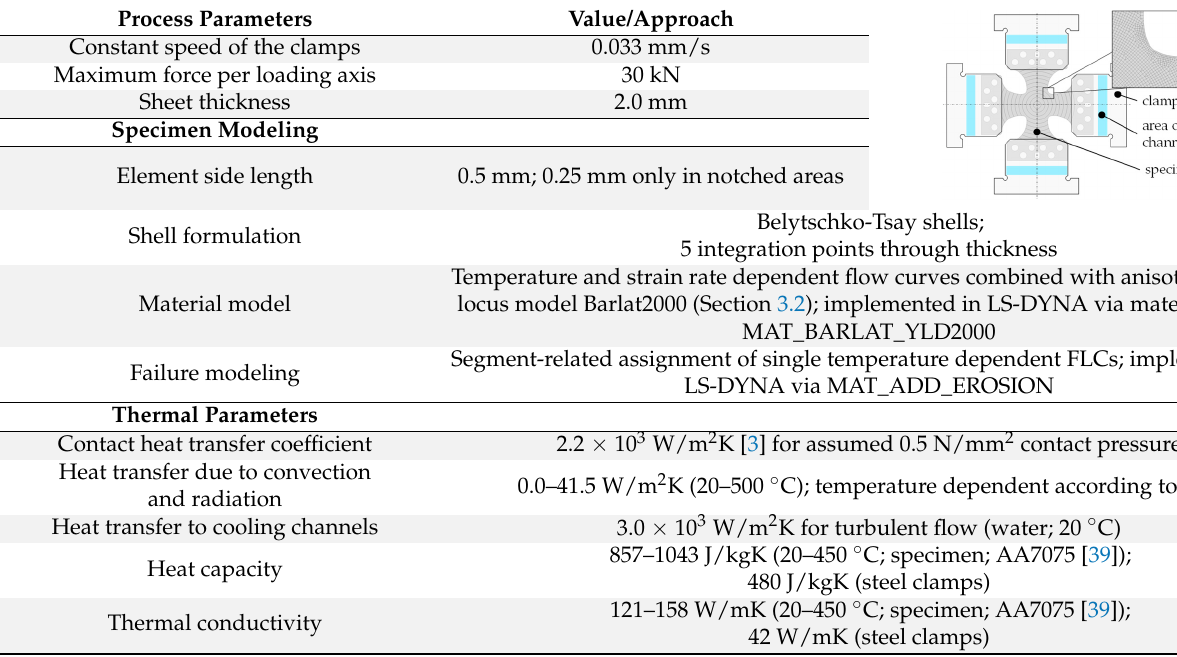
Table 3. Main simulation parameters and approaches.